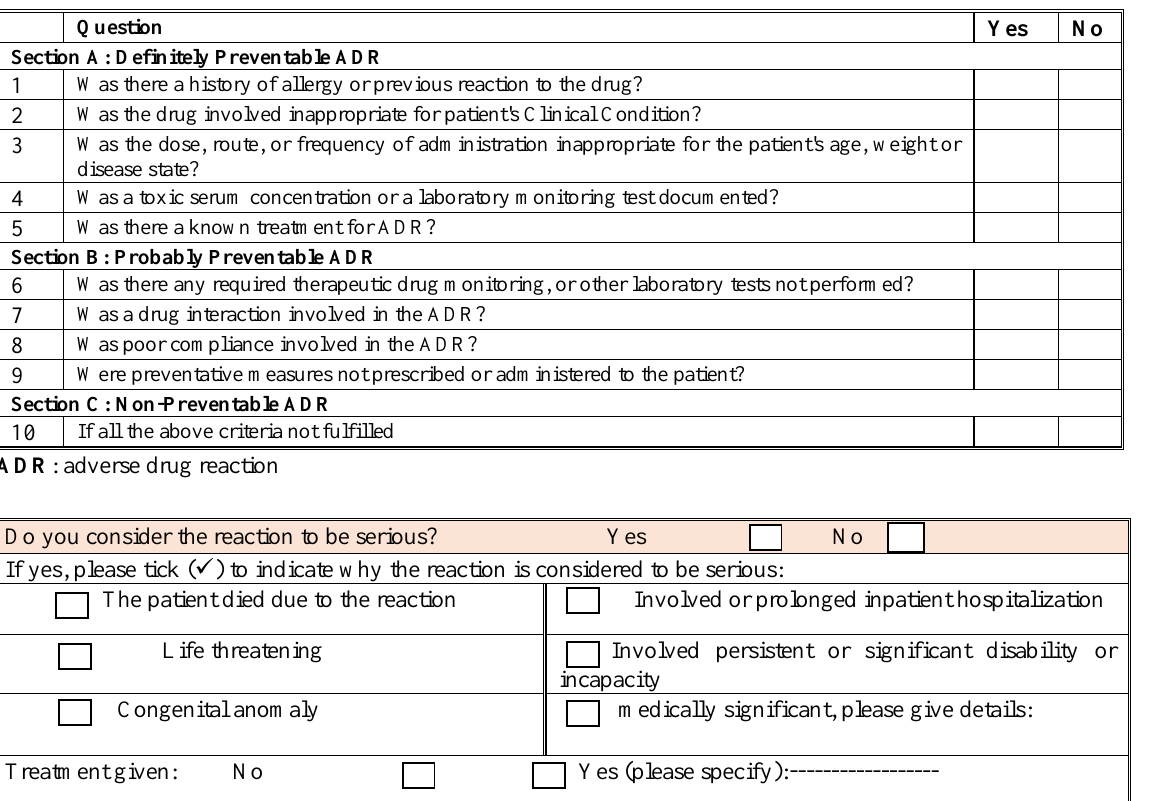
Table 2. Schumock and Thornton preventability assessment criteria (19) .